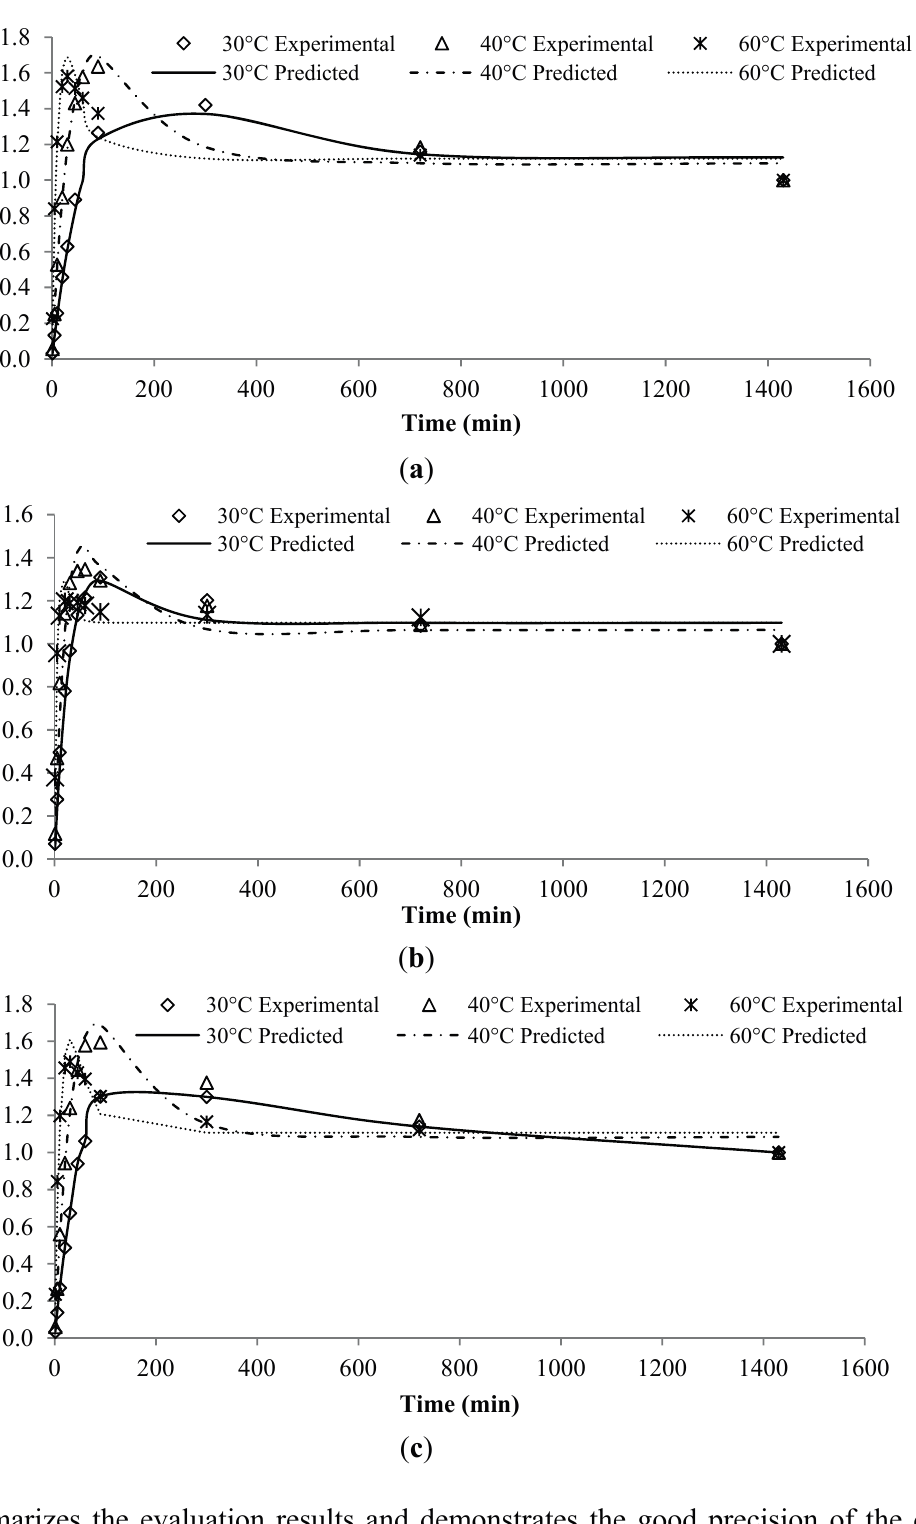
Figure 2. Predicted profile by the second-order kinetic model for flavor release of selected flavor compounds in alcoholic beverage ( a ) isoamylhexanoate; ( b ) allylhexanoate; ( c ) ethyl octanoate. The averaged peak areas are presented as normalized